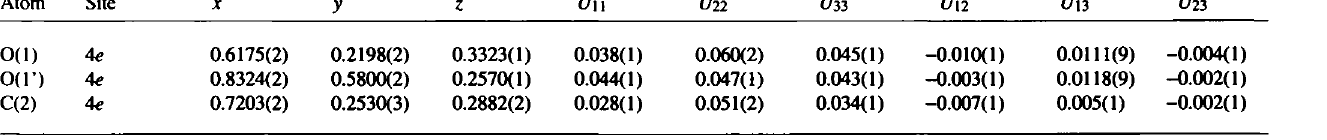
Table 3. Final atomic coordinates and displacement parameters (in Â 2 )